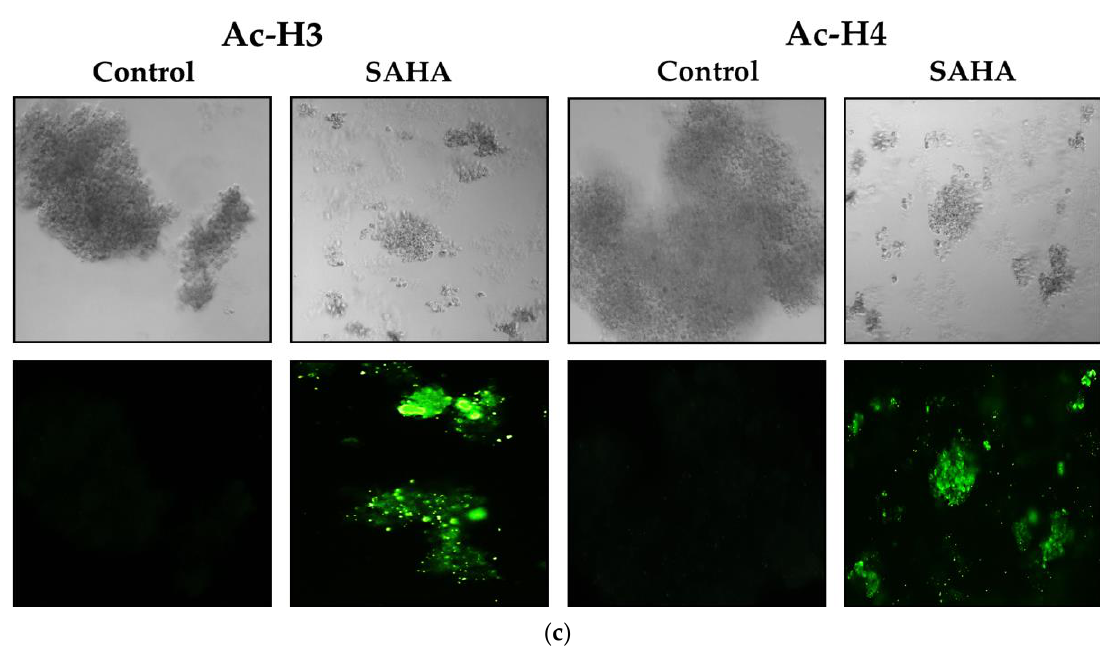
Figure 8. ( a ). HDAC inhibitor SAHA decreased the spheroid formation ability of A2780 cells in vitro. The morphology of A2780 cells treated with SAHA in the pre-and post- spheroid formation process, as observed using the Leica (DMI3000 B) microscope. ( b ). Spheroid formation of A2780 cells stained for acetylated histones. The spheroids were post-treated with SAHA for 7 days and then incubated with specific antibodies for Ac-H2A and Ac-H2B. Light microscopic images of A2780 cells after SAHA (7.5 µM) treatment in the upper panels. Immunocytochemical detection of endogenous period levels for Ac-H2A and Ac-H2B (green fluorescence), visualized using Alexa Fluor ® 488. ( c ). Spheroid formation of A2780 cells stained for acetylated histones. The spheroids were post-treated with SAHA for 7 days and then incubated with specific acetylated histones antibodies such as Ac-H3 and Ac-H4. Light microscopic images of A2780 cells after SAHA (7.5 µM) treatment in the upper panels. Immunocytochemical detection of endogenous spheroid levels for Ac-H3 and Ac-H4 (green fluorescence), visualized using Alexa Fluor ® 488. The spheroids were observed on a Leica (DMI3000 B) microscope at a magnification of 10×.